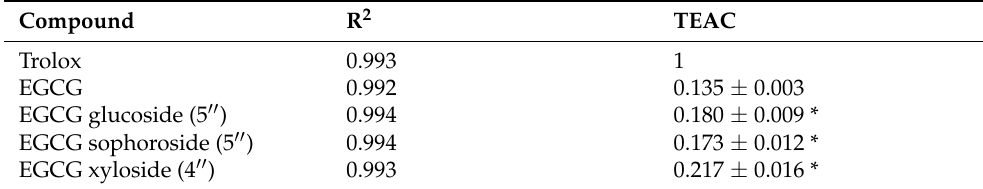
Table 1. Antioxidant activity of EGCG and its glycosides using ABTS • + as substrate. Compound R 2 TEAC Trolox 0.993 1 EGCG 0.992 0.135 ± 0.003 EGCG glucoside (5 (cid:48)(cid:48) ) 0.994 0.180 ± 0.009 * EGCG sophoroside (5 (cid:48)(cid:48) ) 0.994 0.173 ± 0.012 * EGCG xyloside (4 (cid:48)(cid:48) ) 0.993 0.217 ± 0.016 * Data expressed as mean ± SD ( n = 4, * p < 0.01 vs.